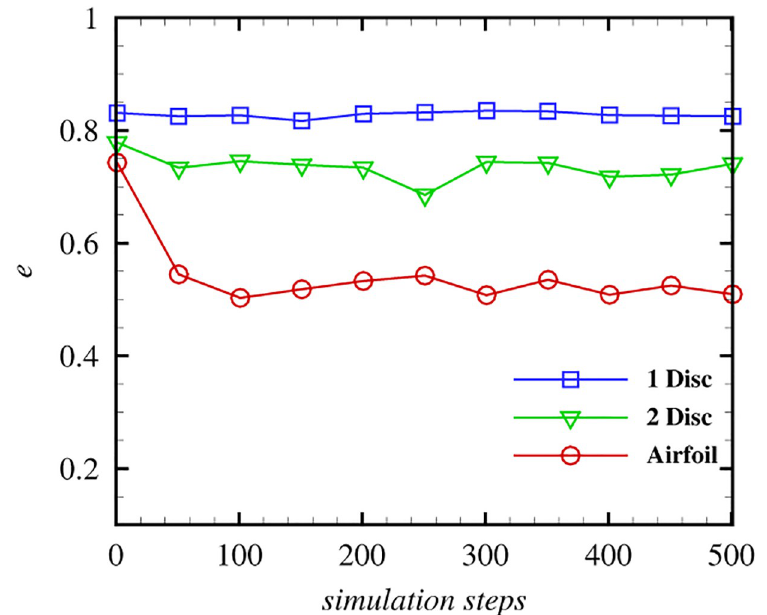
Fig 11. Comparison of the elimination ratio with different 2D